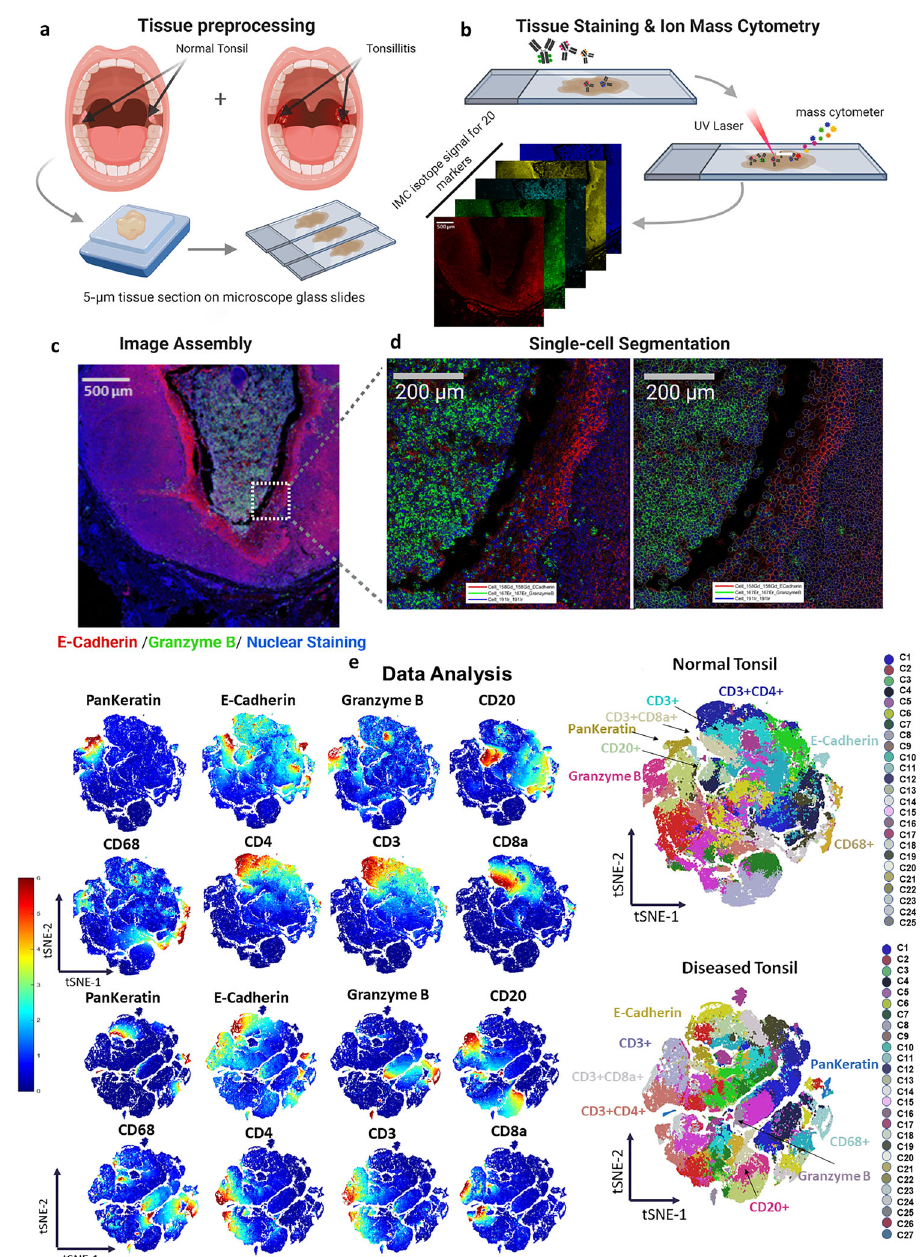
Fig. 1 The immune-epithelial landscape of healthy tonsil and chronic tonsillitis. a Tissue samples were obtained from healthy and diseased tonsils (chronic tonsillitis) in 5- µ m-thick formalin- fi xed, paraf fi n-embedded samples. b The thin tissue sections were then stained with metal-conjugated antibodies and get ablated from the tissue ’ s surface through the argon plasma and analyzed by the time of fl ight mass spectrometer. c Individual marker images can be assembled and visualized using different colors to observe the marker ’ s coexpression and spatial organization. d Cells were segmented using CellPro fi ler software for single-cell quanti fi cation. e Single-cell analyses provide the marker expression distributions, including phenotype clustering based on the coexpression of markers. Phenographs of all normal and diseased ROIs show the different phenotypes that make up the sample to n = 25 – 27 groups. Immune and stromal markers were selected to cluster the entire dataset of the normal and diseased tonsil. The markers list includes CD20, CD68, CD3, CD4, CD8a, granzyme B, pankeratin, and E-cadherin. Created in